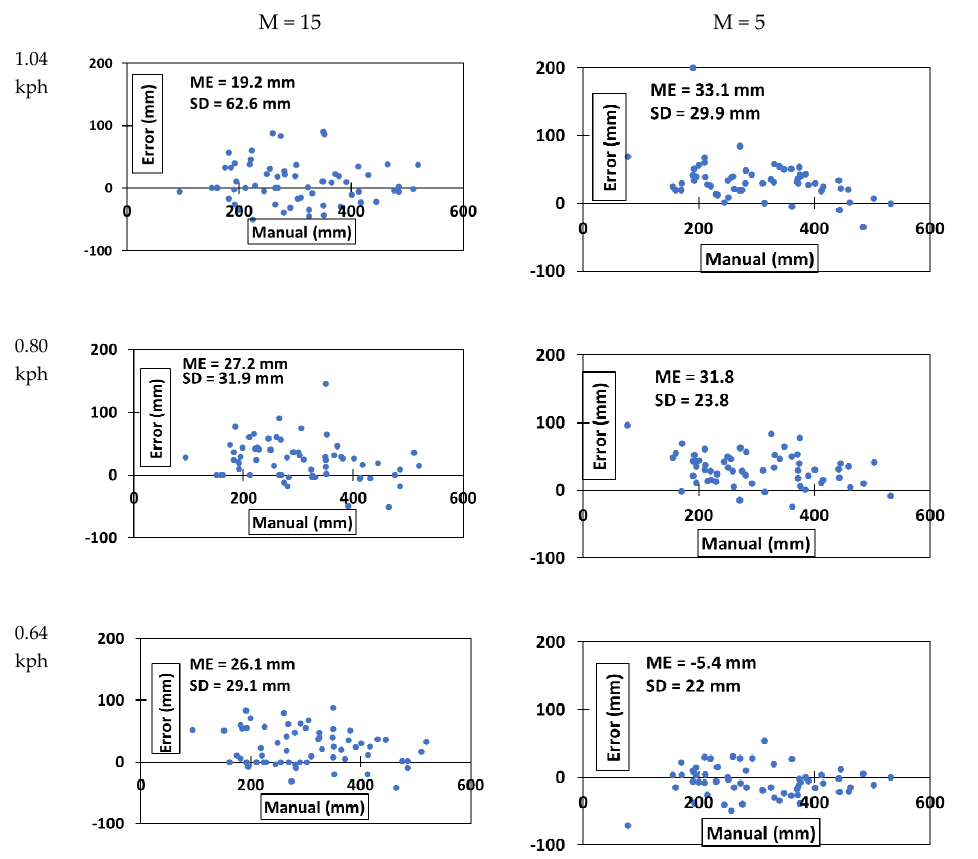
Figure 15. The mean error distribution of the experiment (M = 5) and the 15 pixel contour for 1.04 kph (fast speed), 0.80 kph (slow speed), and 0.64 mph (very slow speed) of cotton boll position measurements).